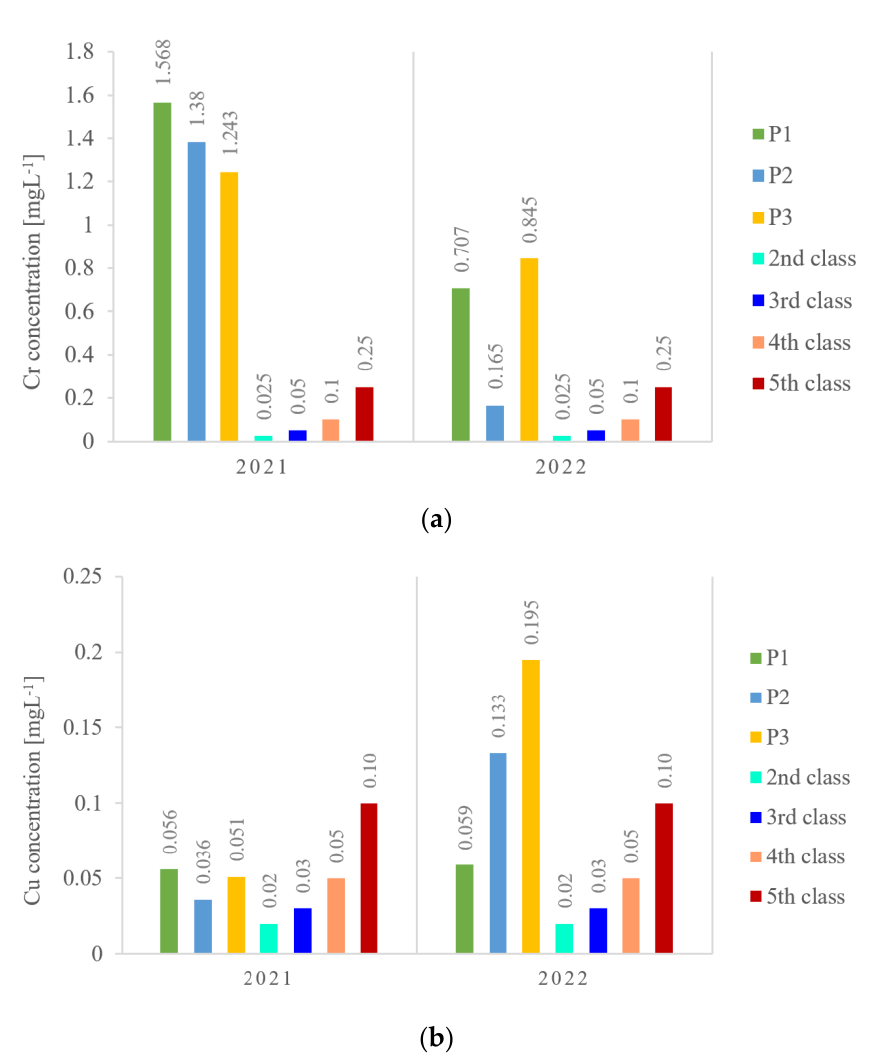
Figure 3. Heavy metal in studies surface water samples compared quality classes established by the Minister Order 161/2006/OD: ( a ) Cr concentration, ( b ) Cu